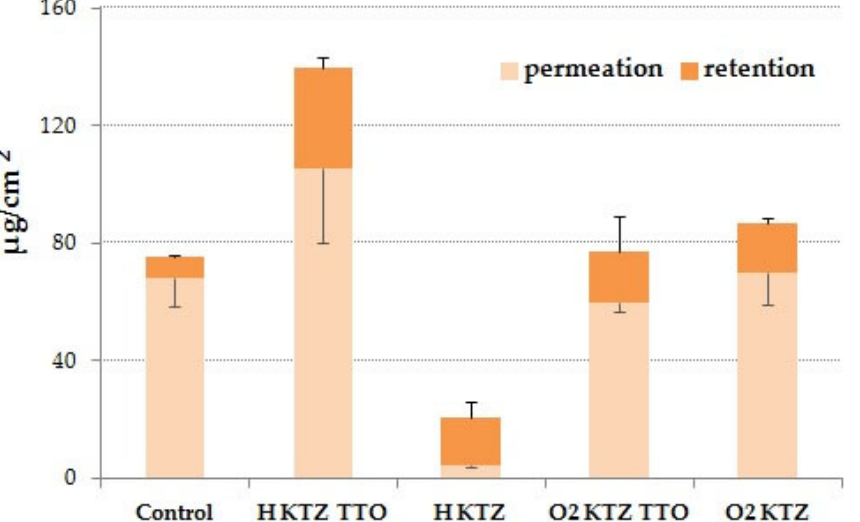
Figure 7. In vitro permeation and retention (expressed as total amount of agent permeated or accumulated per unit membrane area) of ketoconazole (KTZ) from hydrogel (H) and organogel (O2) formulations with pure drug or combination of drug and tea tree oil (TTO) in membrane imitating human skin attained after 24 h; C—commercial topical preparation with KTZ. Values are expressed as means ± SD of six replicates; p ˂ 0.05.